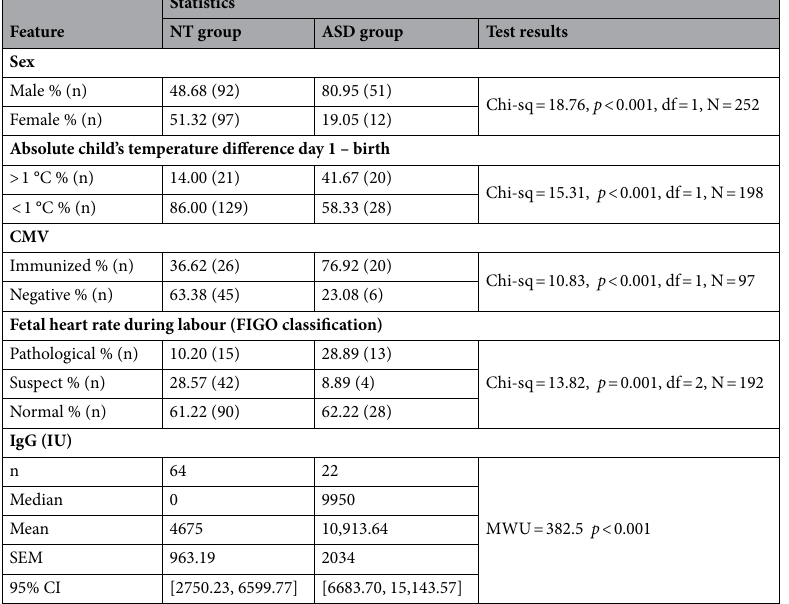
Table 3. Results of the statistical tests for features which are significantly different between NT and ASD groups. n, number of samples; SEM, standard error of mean; CI, confidence interval; Chi-sq, Chi-squared test; MWU, statistics of Mann–Whitney U test.